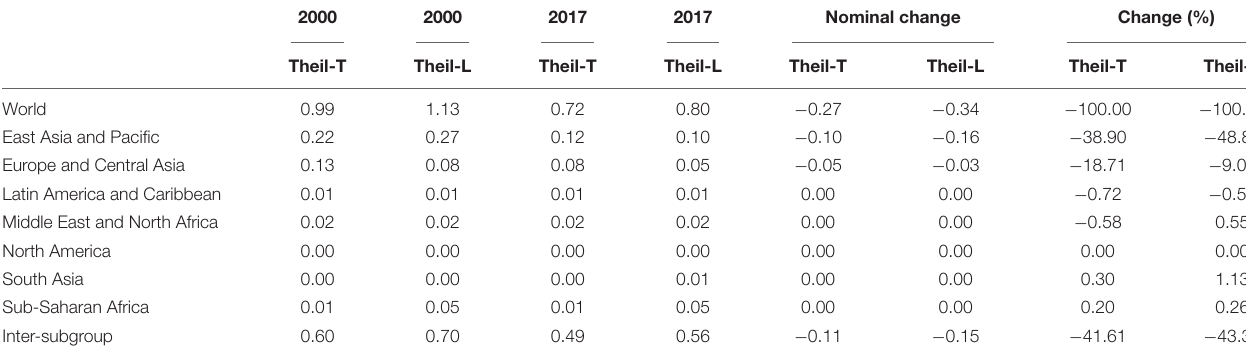
TABLE 4 | Decomposition of change in inequality for seven regional subgroups,